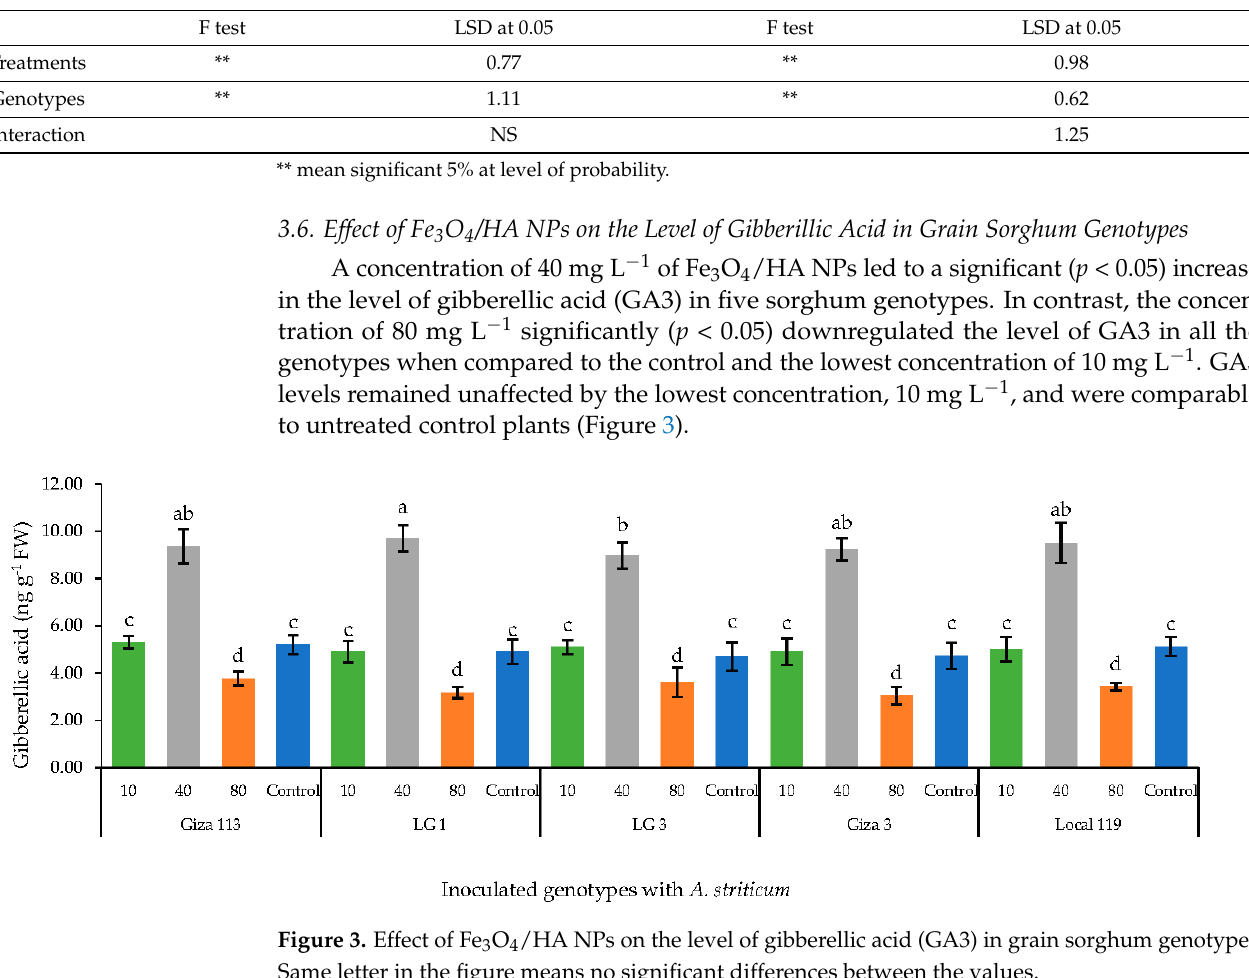
Figure 3. Effect of Fe 3 O 4 /HA NPs on the level of gibberellic acid (GA3) in grain sorghum genotypes. Same letter in the figure means no significant differences between the values.